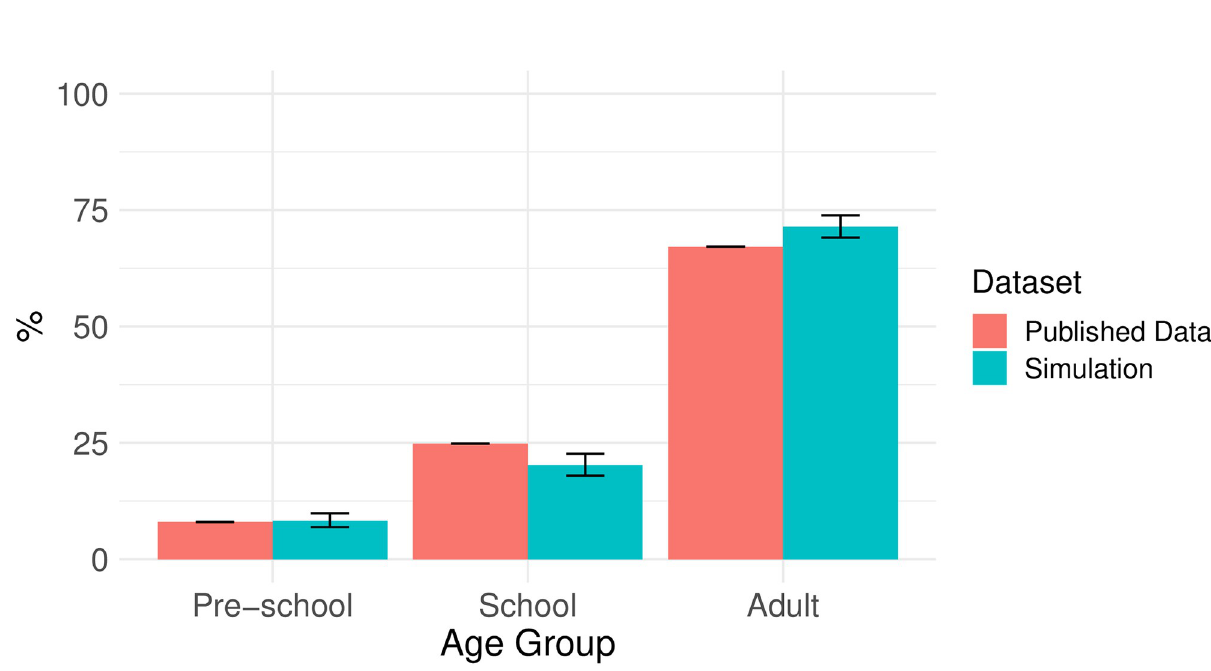
Fig 2. Age distribution. Age distribution (median and 2.5–97.5 quantiles) of simulated data (blue) and age distribution taken from Aboriginal and Torres Strait Islander Health Performance Framework 2017 (red) [39] are presented.